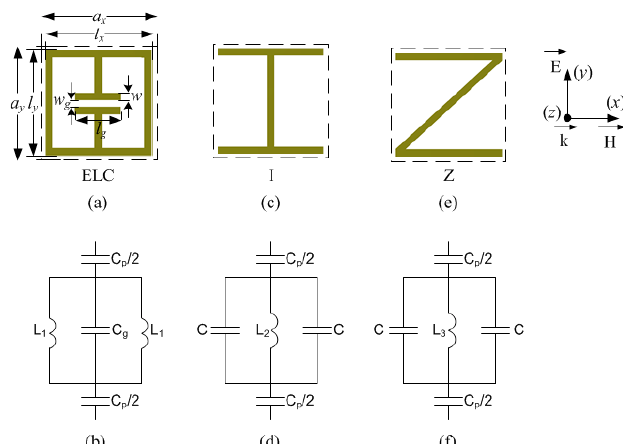
Figure 1: Unit cells and equivalent LC circuit models. (a)- (b) ELC resonator. (c)-(d) I-shaped resonator. (e)-(f) Z- shaped resonator. For all the resonators, the geometrical = a = 6 mm, l = 5.7 mm, l = 5.8 mm, w dimensions are: a x y x y = 0.45 mm and l = 2 = 0.3 mm, w g g